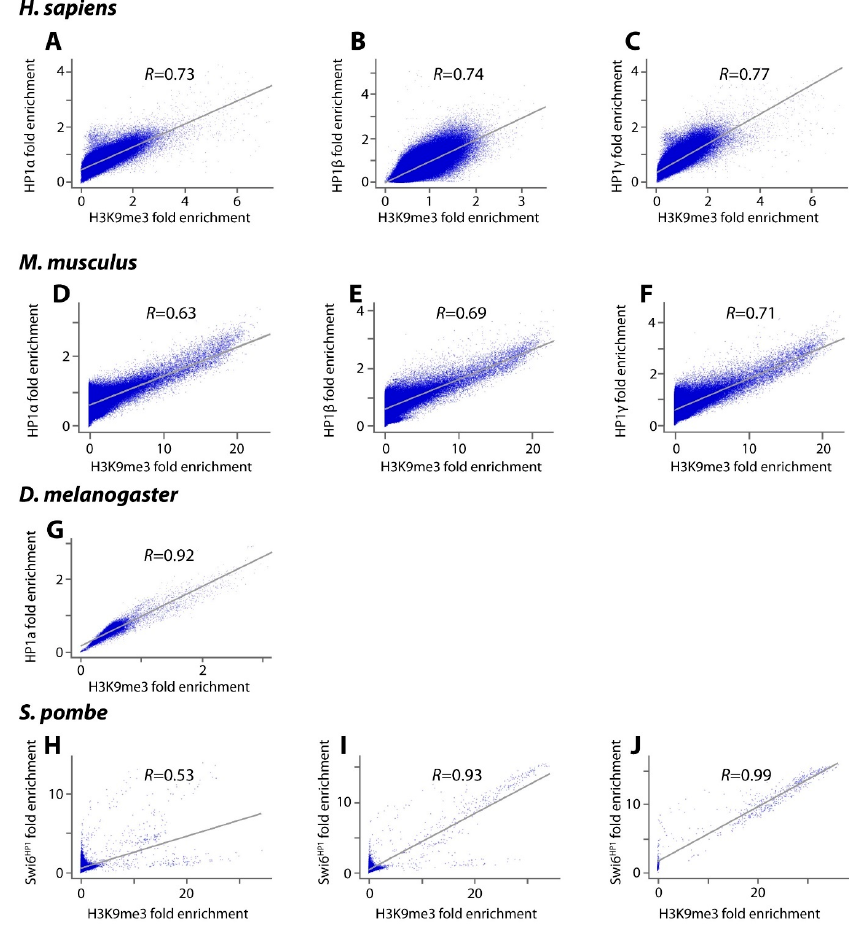
Figure 2. Plots of genome-wide correlation of HP1 proteins and H3K9me3 outside constitutive heterochromatin. The figure depicts fold enrichment of ChIP-seq genome profiles correlated using a 5 kb-sized window for Homo sapiens , Mus musculus , Drosophila melanogaster and a 200 bp-sized window for Schizosaccharomyces pombe . Unless otherwise stated constitutive heterochromatin regions were excluded prior to analysis. ( A – C ) show correlations of HP1 α (H1 ES cells), HP1 β (293T cells) and HP1 γ (H1 ES cells) with H3K9me3 in human cells. ( D – F ) show correlations of HP1 α , HP1 β and HP1 γ with H3K9me3 in mouse ES cells; ( G ) shows correlation of Drosophila HP1a with H3K9me3 in ovaries; ( H ) shows correlation of Swi6 HP1 with H3K9me3 in S. pombe ; ( I ) shows correlation of HP1 β with H3K9me3 over the whole genome of S. pombe ; ( J ) shows correlation of Swi6 HP1 with H3K9me3 over heterochromatin of S. pombe . These data indicate there is a correlation of HP1s with H3K9me3 outside constitutive heterochromatin but that correlation is not absolute. This is consistent with the observation that HP1